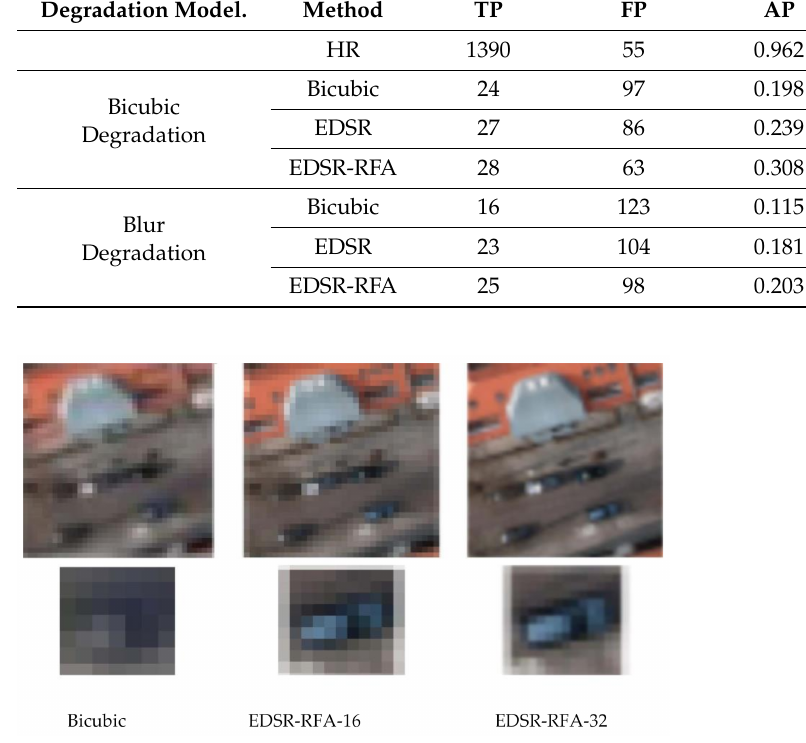
Table 3. Vehicle detection using YOLOv3 SPP (both confidence threshold and IoU threshold were set to 0.25): comparison of results for HR image, the scaled image with a scale factor of 16 × , using bicubic interpolation, EDSR, and EDSR-RFA. Degradation Model.